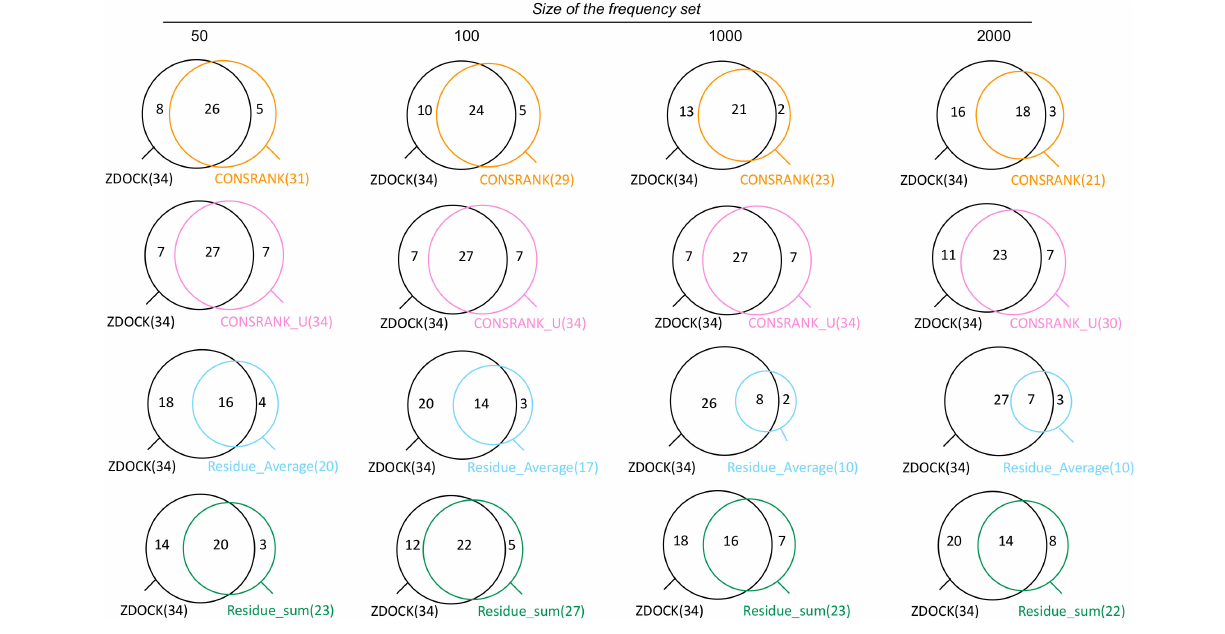
Frontiers in Molecular Biosciences |